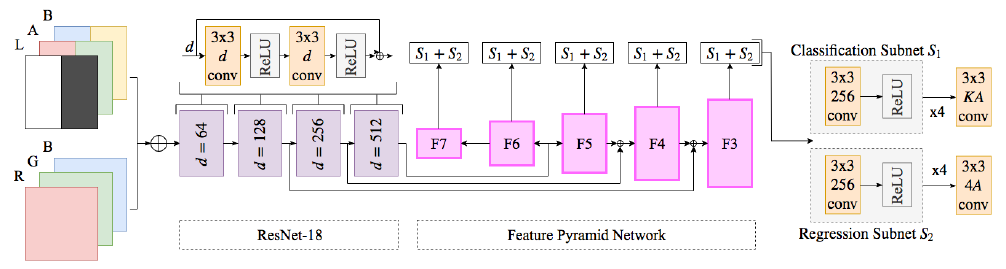
Figure 4. Model Architecture: RetinaNet implementation showing early fusion of RGB and CIELab features, where Fn are convolutional layers with resolution 2 n of the input and 256 channels. F 6 and F 7 are obtained by a 3 × 3 convolutional layer with stride 2 of F 5 and 3 × 3 convolution with stride 2 and intermediate ReLU activation layer of F 6